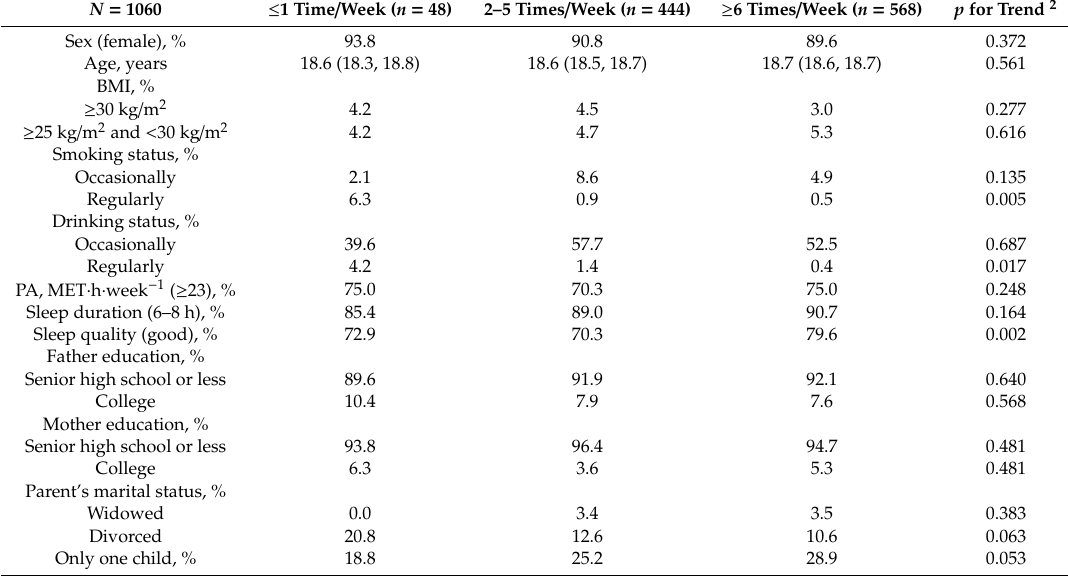
Table 1. Sex and age-adjusted subject’s baseline characteristics according to frequency of consumption of breakfast 1 .